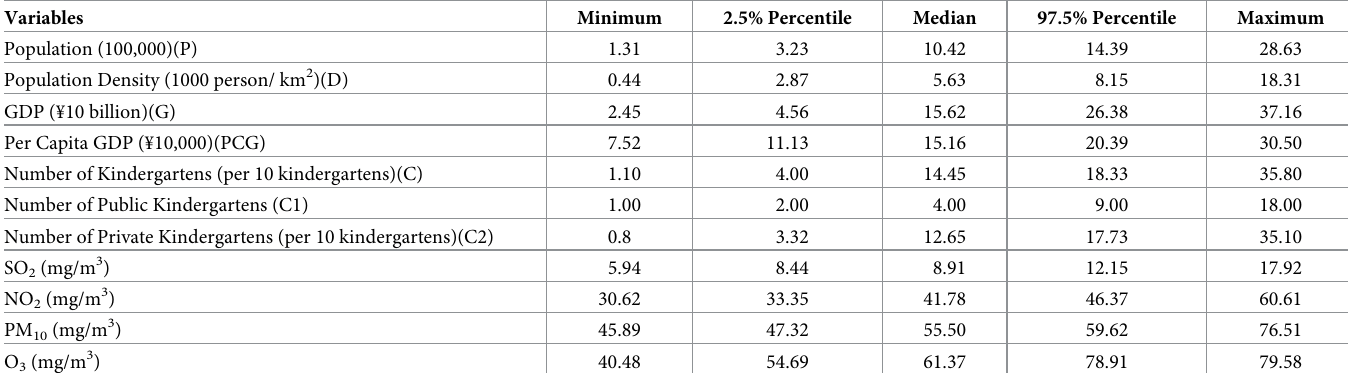
Table 2. Descriptive statistics of the socioeconomic and air pollution variables.